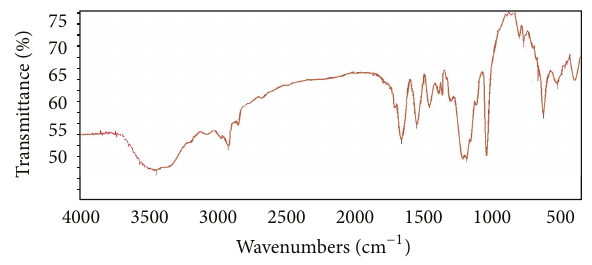
Figure 1: FTIR spectrum of Fe 3 O 4 /p(AMPS) nanogel.